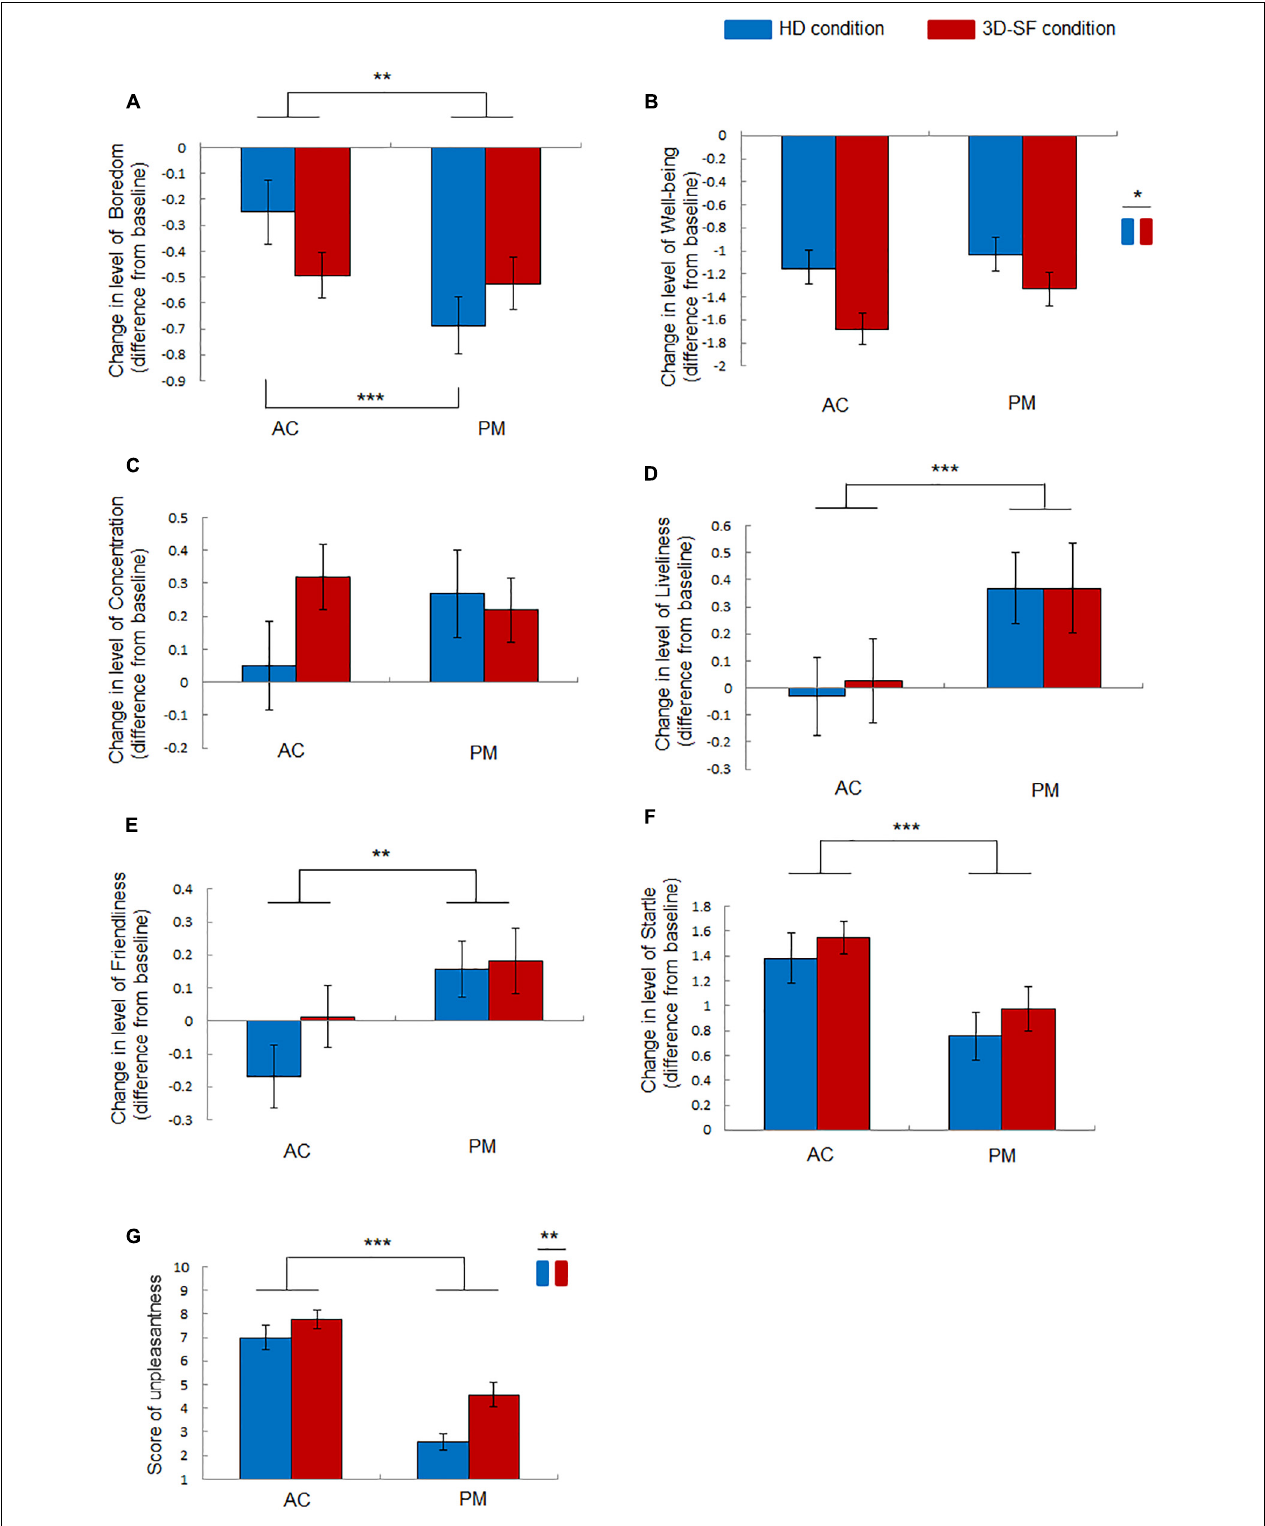
FIGURE 4 | Effect of music listening on moods and unpleasantness of music. (A–F) Change in the level of (A) Boredom, (B) Well-Being, (C) Concentration, (D) Liveliness, (E) Friendliness, and (F) Startle after music listening (AC or PM) in the different conditions (3D-SF or HD) compared with the level before it. (G) Felt unpleasantness of music rated after listening to music. Data are presented as means ± SEM; *** p < 0.001, ** p < 0.01, * p < 0.05.